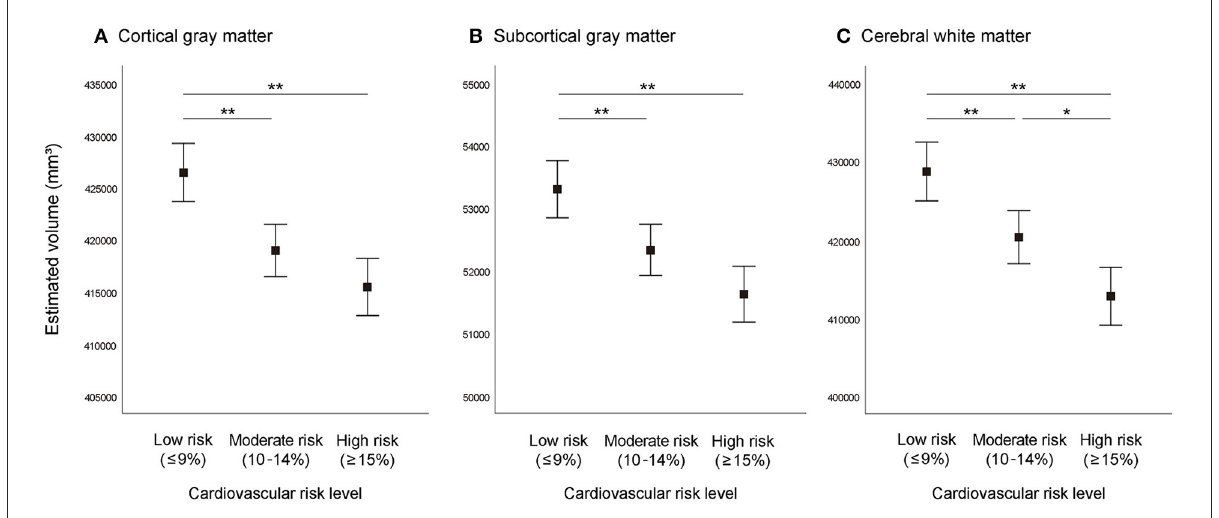
FIGURE1 Brain volume according to absolute cardiovascular risk level. (A) Cortical gray matter, (B) subcortical gray matter, (C) cerebral white matter. Graphs represent estimated mean values and 95% confidence intervals adjusted for total cranial volume. ** P < 0.01, * P <